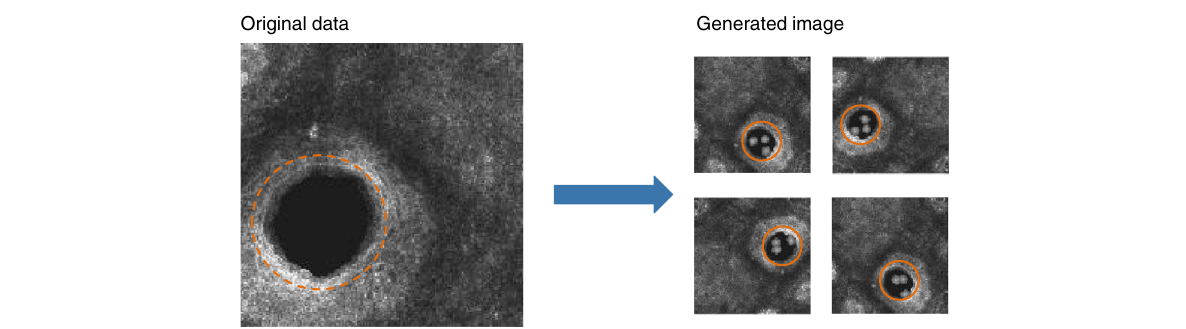
Fig. 7 Comparison of the original images and generated images based on zero sample. On the left of this figure is the original background image, and on the right of this figure shows the effect of the picture containing the demodicosis generated by ZSAL